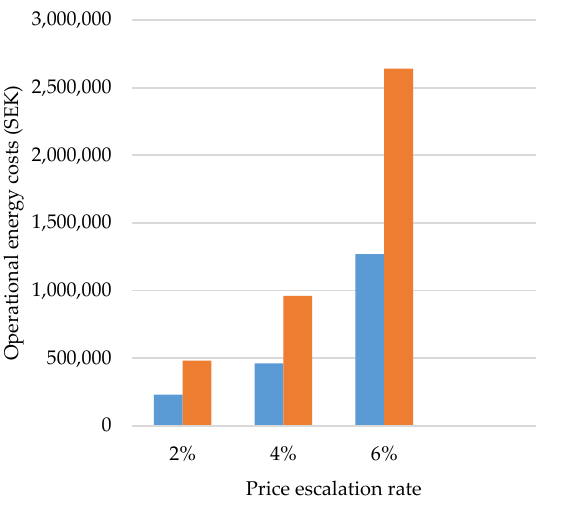
Figure 5. Total electricity costs estimation for a 100 years lifespan. The results show that escalated energy rate will have an evident impact on the operational energy costs. It is clear that when increasing the escalation rate, the future energy costs grow significantly when using 3% discount rate and price escalation rate of 6%. If the installed PV panels are excluded as an alternative in the calculation, additional energy has to be purchased from the grid. Without the PV panels, the operational energy costs will increase significantly, almost double when having a 5% discount rate and a 100-year lifespan (Figure 6).